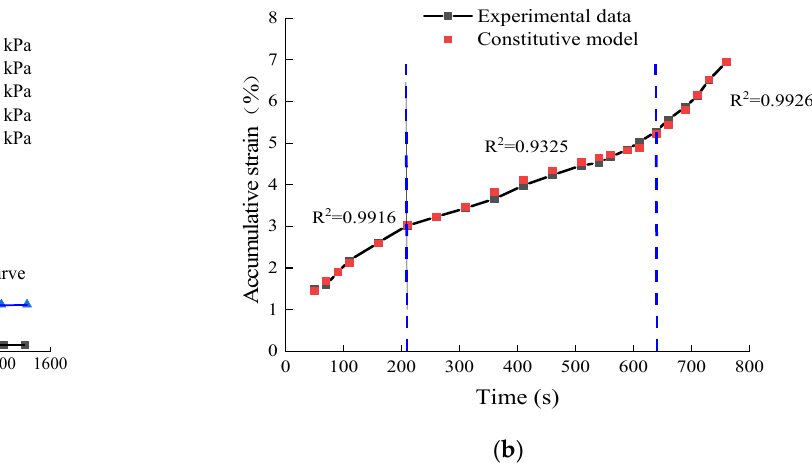
Figure 12. ( a ) Predication of dynamic constitutive model in Zhan Jiang clay; ( b ) Comparison between experimental data and fitting results ( σ _3 = 100 kPa, σ _1/ σ _3 = 0.5).